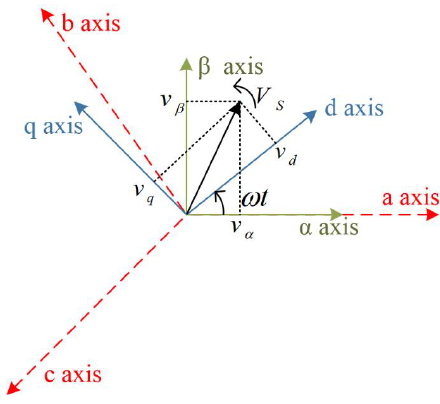
Figure 3. Frame of